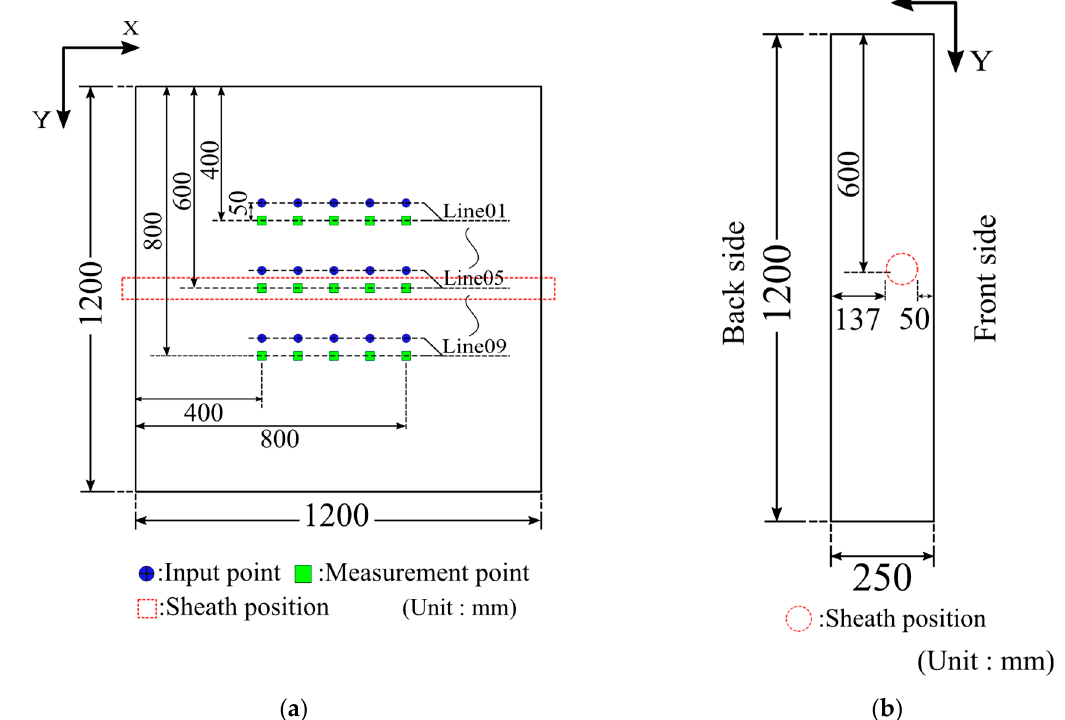
Figure 9. Schematic diagram of the specimen_1 and specimen_2: ( a ) Front side of specimen; ( b ) Cross-section view of configuration and the sheath.